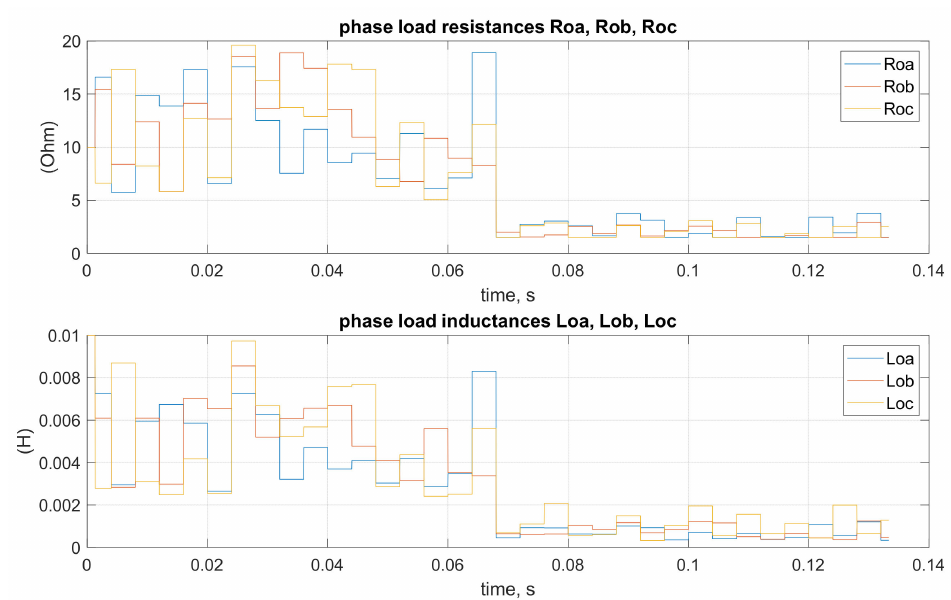
Figure 14. Waveforms of load phase resistances and inductances with a steep load increase at the time of 0.068 s.